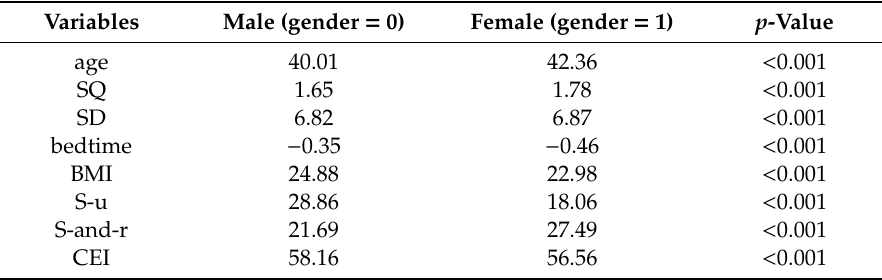
Table 3. T -test analysis by gender.